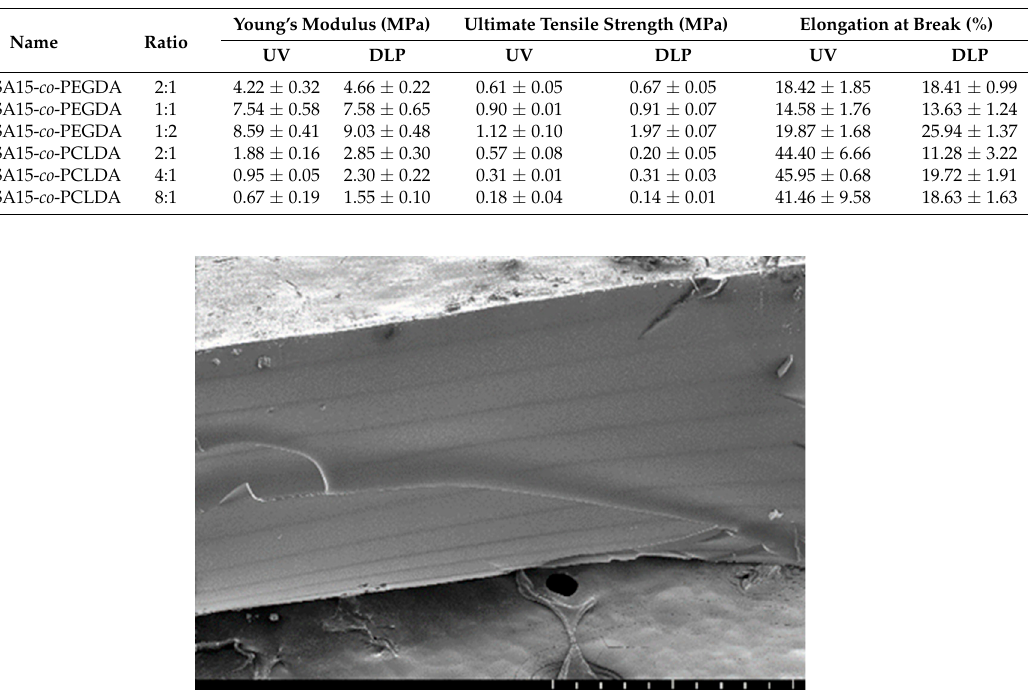
Table 6. Comparison between the mechanical properties of UV-cured and DLP-AM printed PGSA15- Comparison between the mechanical properties of UV-cured and DLP-AM printed co -PEGDA and PGSA15- co -PCLDA in various weight ratio ( n = 5). PGSA15- co -PEGDA and PGSA15- co -PCLDA in various weight ratio ( n = 5).